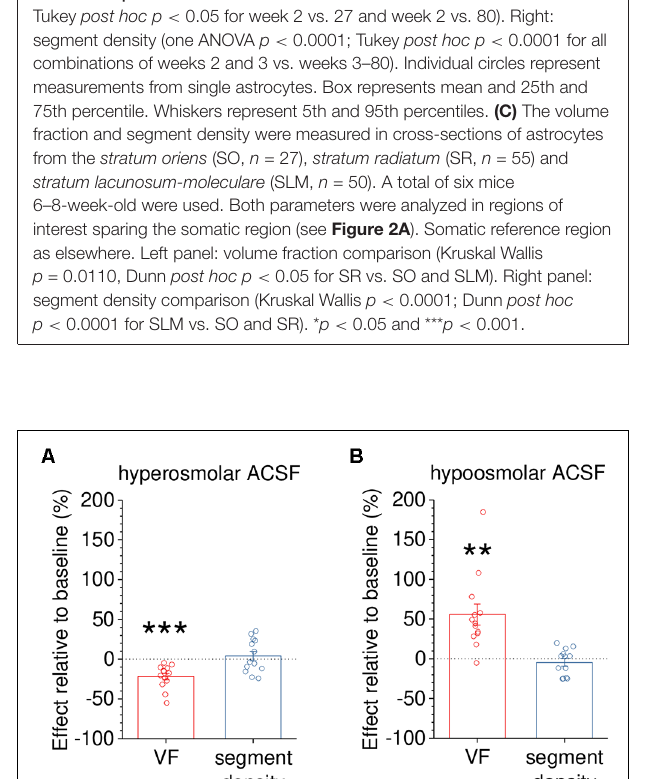
FIGURE 6 | Capturing dynamic changes of astrocyte volume in response to altered extracellular osmolarity. To demonstrate that volume fraction (VF) measurements are a sensitive indicator of volume changes of small astrocyte processes, astrocytes were acutely exposed to hyper- or hypoosmolar extracellular solution (see “Materials and Methods” section). The morphology of EGFP-expressing astrocytes (not illustrated) was analyzed before (baseline) and 10 min after changing the extracellular solution. Changes in VF and segment density were expressed as per cent change relative to the baseline recording. (A) The VF was significantly reduced by application of hyperosmolar solution ( ∼ 400 mOsm/kg, − 21.8 ± 4.1%, p < 0.001) whereas the segment density was not (+4.0 ± 5.8%, p = 0.510, n = 13 and paired Student’s t -test for both tests). (B) In a second set of experiments, the VF of astrocyte processes was increased by exposure to hypoosmolar extracellular solution ( ∼ 200 mOsm/kg, +55.8 ± 13.2%, p = 0.00117) whereas the segment density was not affected ( − 4.5 ± 4.6%, p = 0.351, n = 13 and paired Student’s t -test for both tests). Overall, changes of VF and segment density did not display a statistically significant correlation (Spearman’s rank correlation, R = − 0.246, p = 0.226, n = 26). Also, see Supplementary Figure 1C . ** p < 0.01 and *** p <